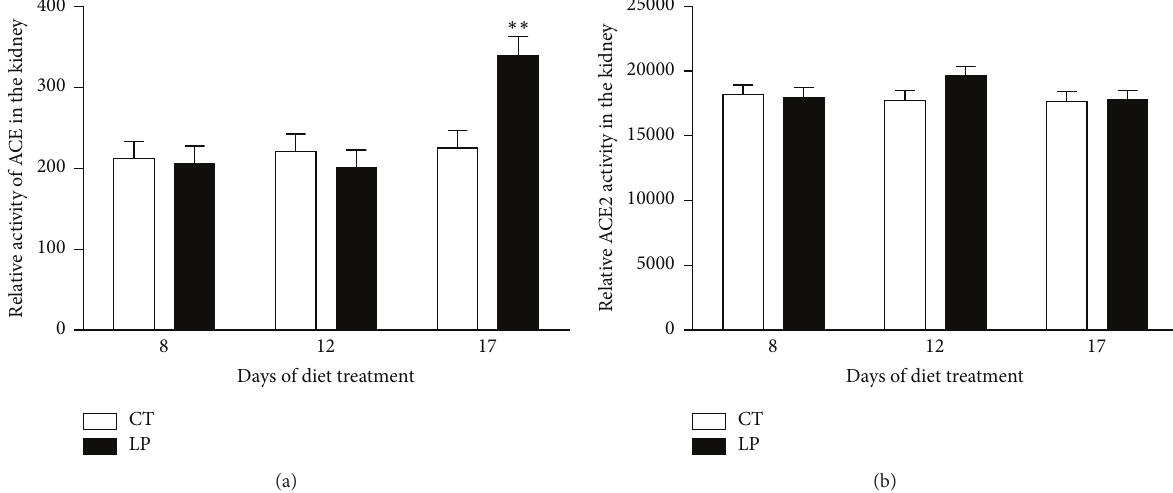
Figure 4: Relative activities of ACE and ACE2 in the kidney of nonpregnant rats fed a low-protein diet. CT: control; LP: low protein. The error bar represents the mean ± SEM ( 𝑛 = 6 rats/diet group/day). ∗∗ 𝑃 < 0.01 .